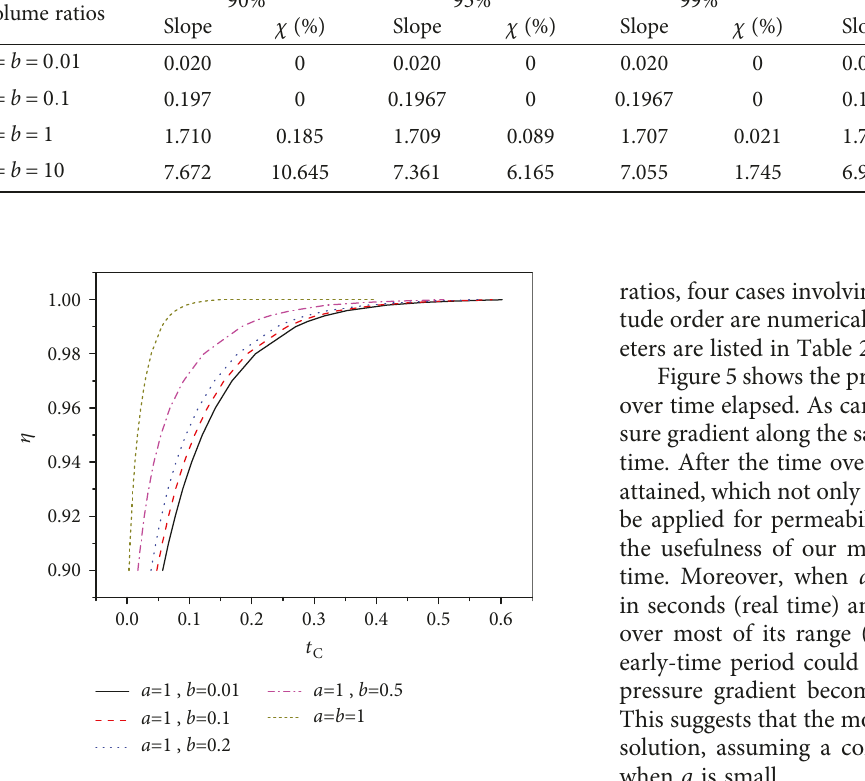
Figure 4: Critical time of cases with unequal chamber